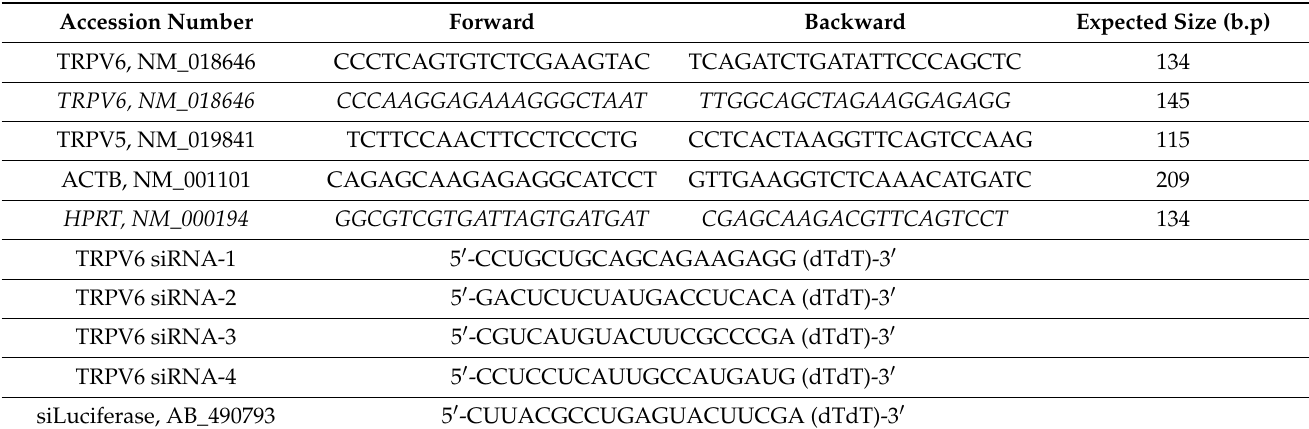
Table 1. Primers and siRNA (in italics, primers for